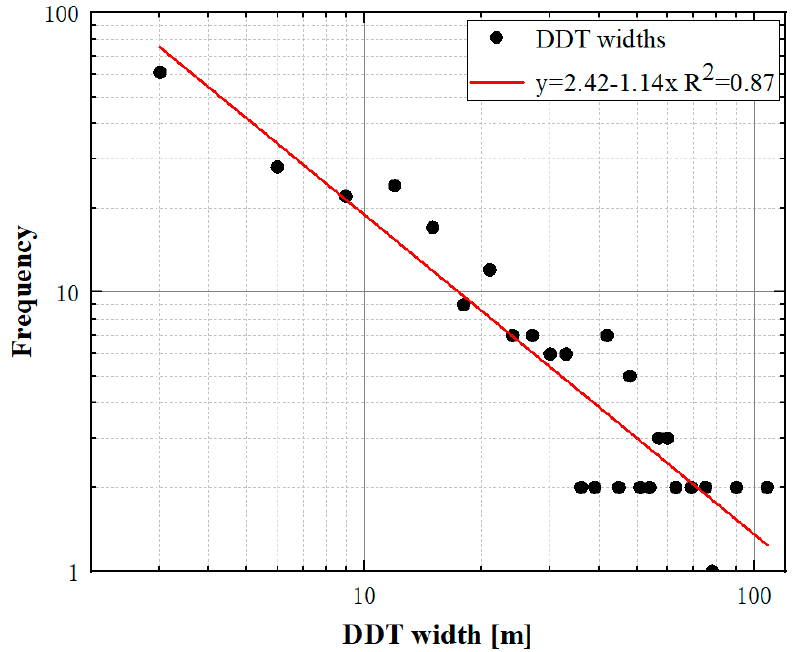
Figure 5. DDT frequency versus DDT widths of all identified DDTs (black circles) in 3 m bin sizes. The red line is a power law with an exponent of − 1.14. The R 2 value of the fitting formula is equal to 0.87.